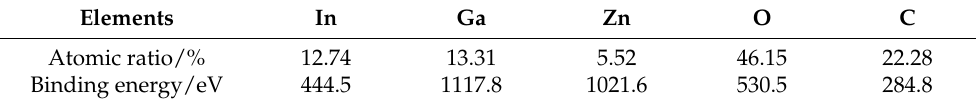
Table 3. Electrical properties of a-IGZO films under different oxygen flows. Oxygen Flow /sccm